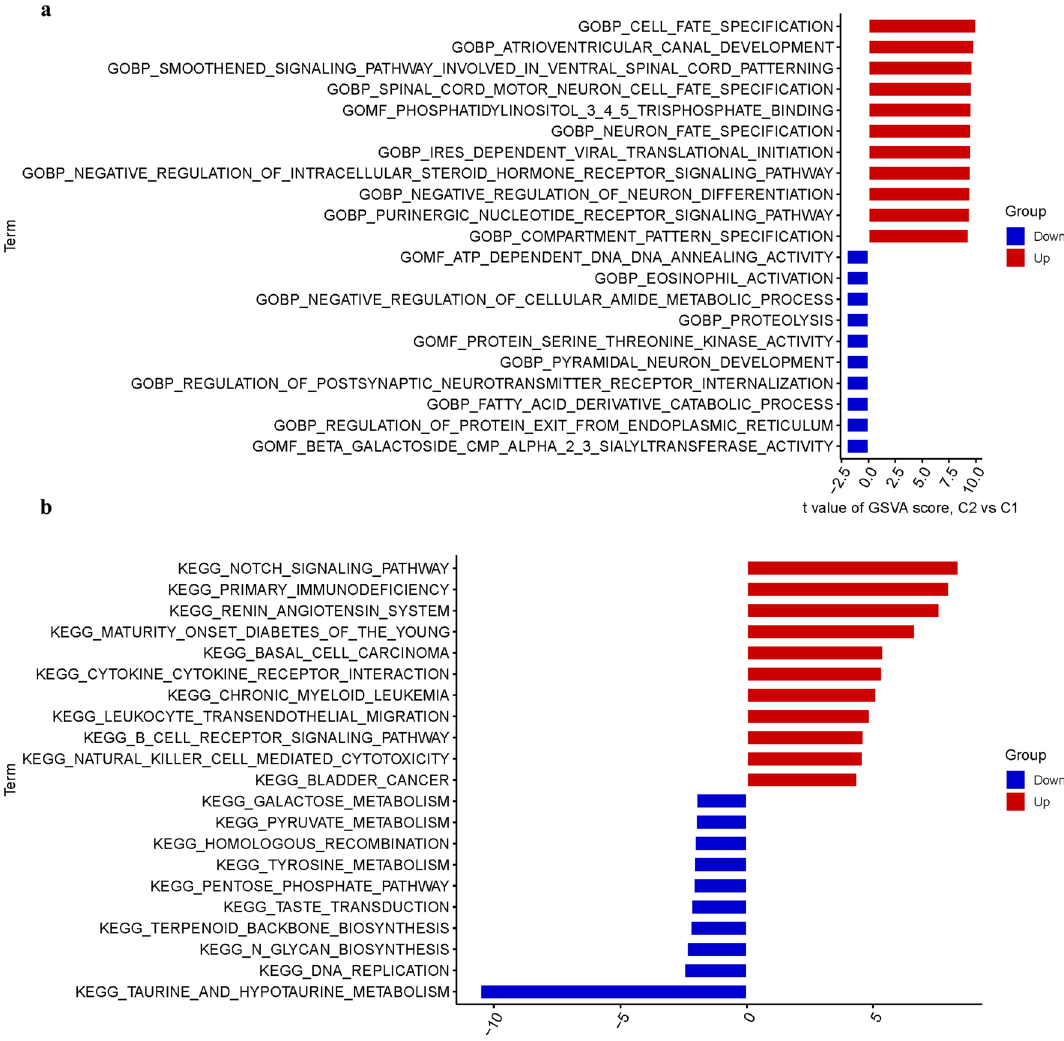
Figure 6. Enrichment analysis for DEGs. ( a ) GO. ( b ) KEGG. ( a ) Barplot graph for GO enrichment (the longer bar means the more genes enriched; q-value: the adjusted p-value). ( b ) Barplot graph for KEGG pathways (the longer bar means the more genes